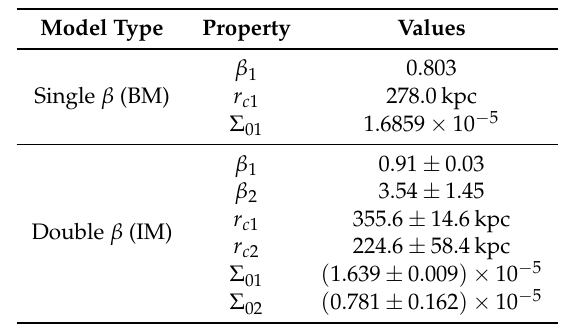
Table 1. Values of parameters obtained from the fitting in Figure 3b. The values of Σ are multiples of 10 15 M (cid:12) /px 2 .